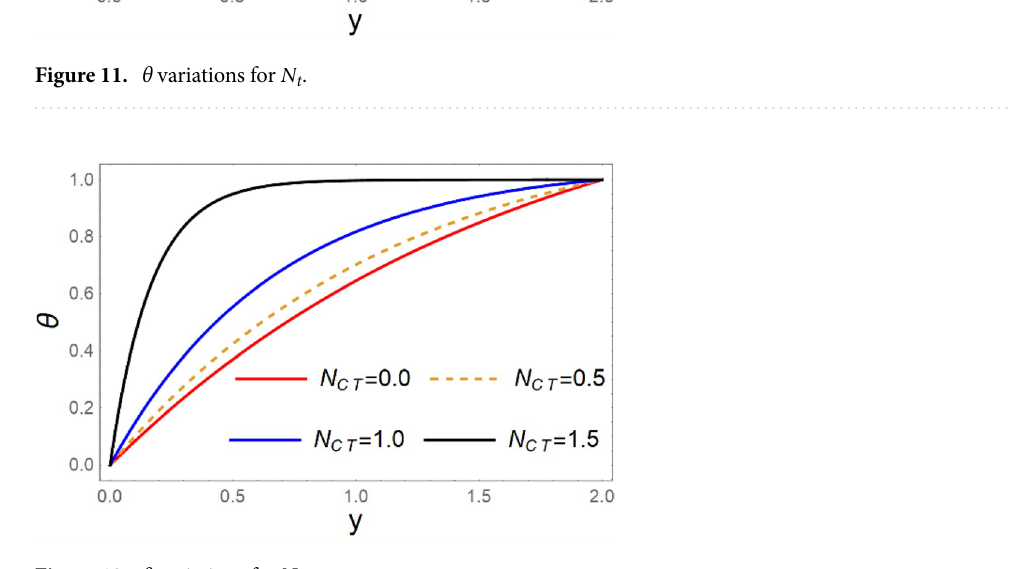
Figure 12. θ variations for N CT